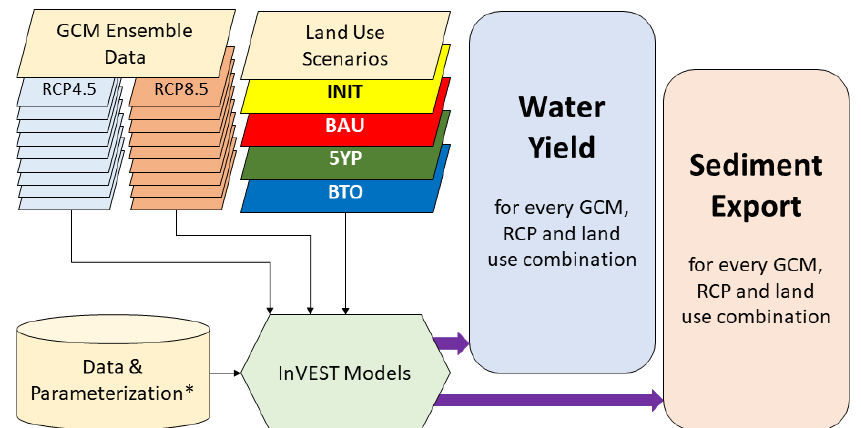
Scheme 1. Comprehensive scheme of the modeling methodology used in this study. Model inputs are depicted as black arrows. Model outputs are depicted as purple arrows. * Data & parameterization is based on Thellmann et al.